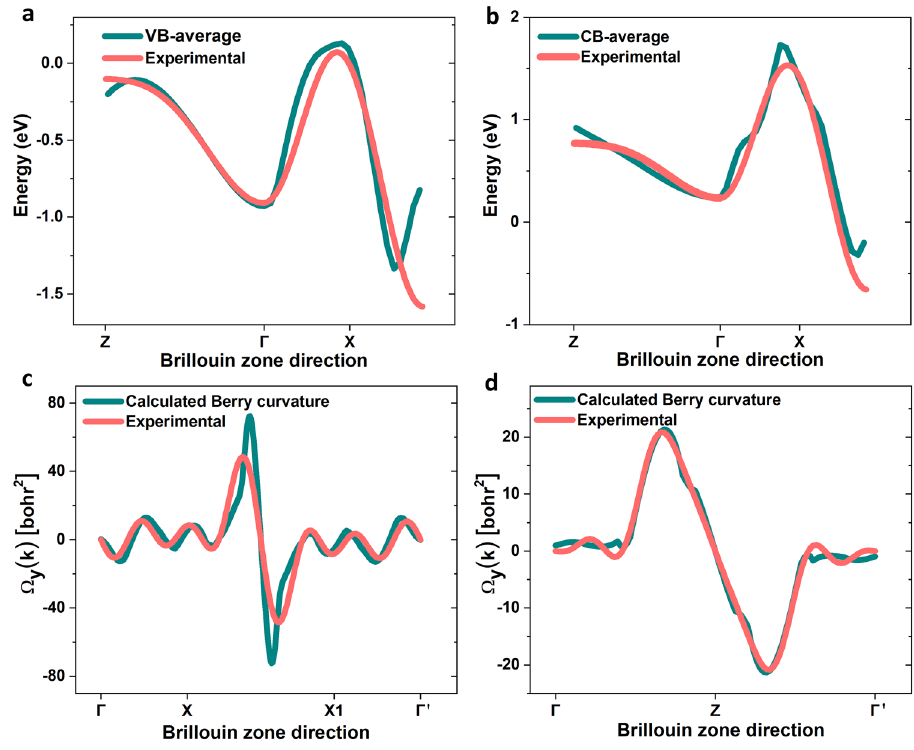
Fig. 5 Theoretical and experimental electronic structure and Berry curvature of β -WP 2 . a , b The blue lines are the electronic dispersion curves of the conduction and valence bands crossing the Fermi energy ( E F = 0) obtained by fi rst-principles calculation. The red lines are the electronic dispersion curve retrieved by fi tting the θ -dependent odd-order HHG of β -WP 2 crystals. The two results fi t well. c , d The blue lines are the theoretically calculated Berry curvature of β -WP 2 . The red lines are the experimental Berry curvature of β -WP 2 fi tted by even-order HHG, which is in good agreement with the theoretical